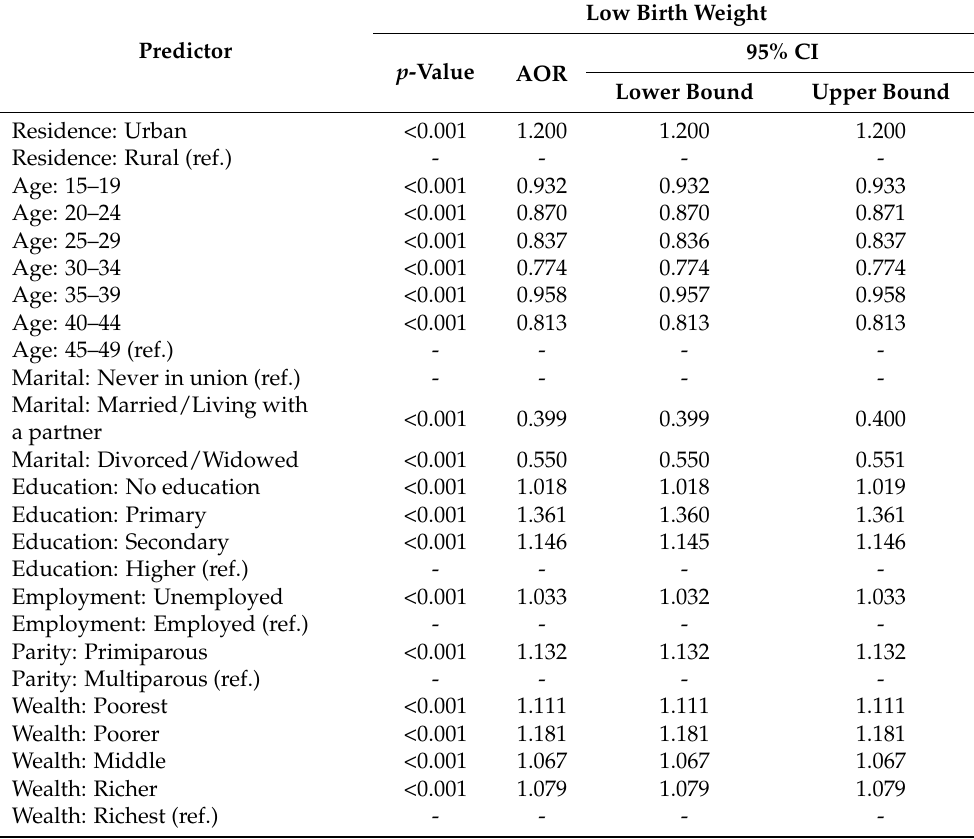
Table 2. The result of binary logistic regression on LBW in Indonesia,